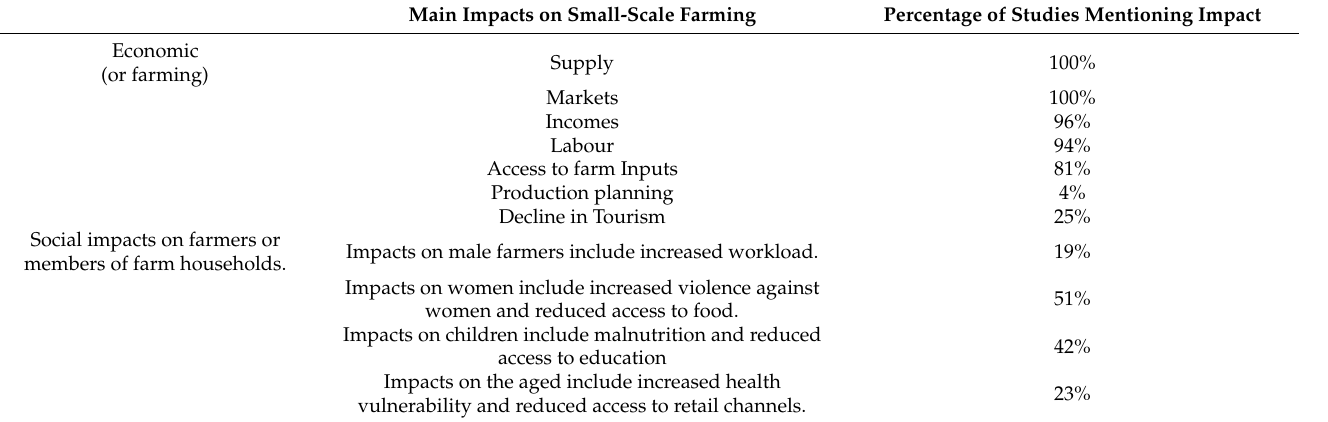
Table 2. Main impacts of COVID-19 on small-scale farmers and members of farm households. Main Impacts on Small-Scale